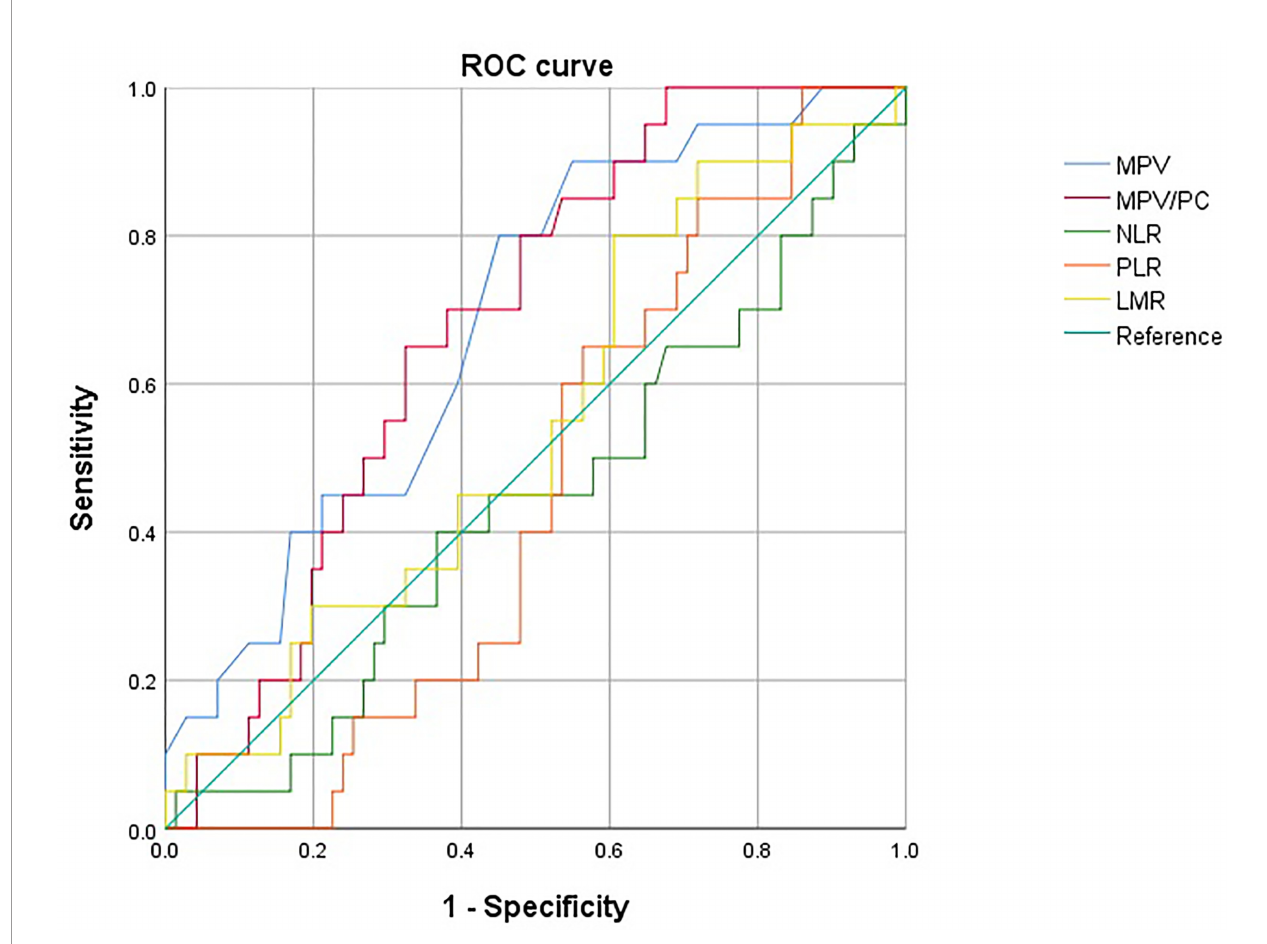
FIGURE 2 | Receiver operating characteristic (ROC) curves of MPV, MPV/PC, NLR, PLR, and LMR. The optimal cutoff levels for MPV and MPV/PC were 10.15 [sensitivity: 90.0%, speci fi city: 45.1%, Area under the curve (AUC): 0.687, 95% CI (0.563, 0.810)] and 0.41 [sensitivity: 65.0%, speci fi city: 67.6%, Area under the curve (AUC): 0.682, 95% CI (0.568, 0.796)], respectively. MPV, Mean platelet volume; MPV/PC, Mean platelet volume-to-platelet count ratio; NLR, Neutrophil-to- lymphocyte ratio; PLR, Platelet-to-lymphocyte ratio; LMR, Lymphocyte-to-monocyte